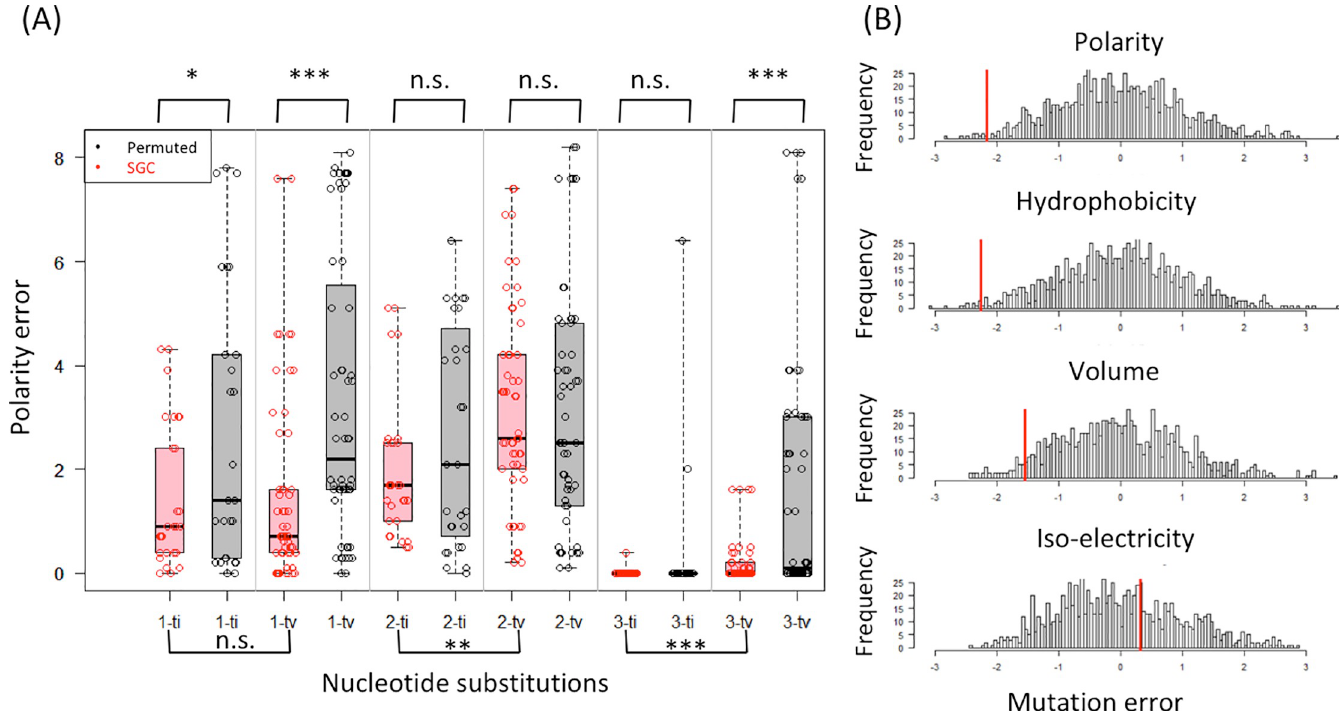
Fig 2. Patterns of mutation-error minimization in SGC. (A) On the x-axis, single-nucleotide mutations between pairs of codons are categorized by codon positions (1, 2, and 3) and by transitions (ti) or transversions (tv). The y-axis shows the errors caused by such mutations as quantified by the polarity index (Table 1). Points in red (n = 263) were derived from SGC; points in black (n = 258) by a single round of random permutation of amino acids among the synonymous codon blocks. (B) Distributions of amino-acid errors caused by single-nucleotide substitutions (calculated by Eq 4 with ti/tv = 5) from 1000 permuted codes. These error distributions show SGC significantly reduces mutation errors for polarity (p = 0.010, t -test), hydrophobicity (p = 0.011), and volume (p = 0.048), but not for isoelectric points (p = 0.648).